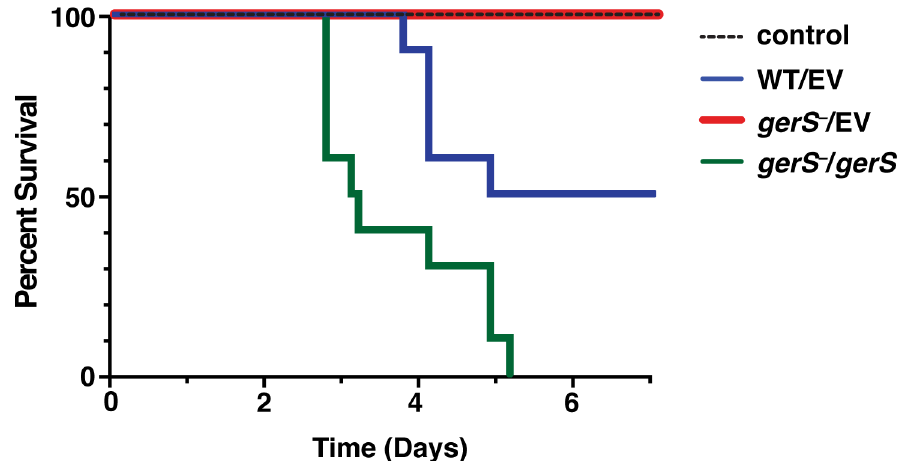
Fig 8. GerS is required for virulence. Kaplan-Meier survival curve of clindamycin-treated Syrian hamsters inoculated with 1,000 isolated spores of wildtype carrying empty vector (WT/EV), the gerS mutant carrying either empty vector ( gerS − /EV), or the wildtype complementation construct ( gerS − / gerS ). The control designates antibiotic-treated hamsters that were not inoculated with